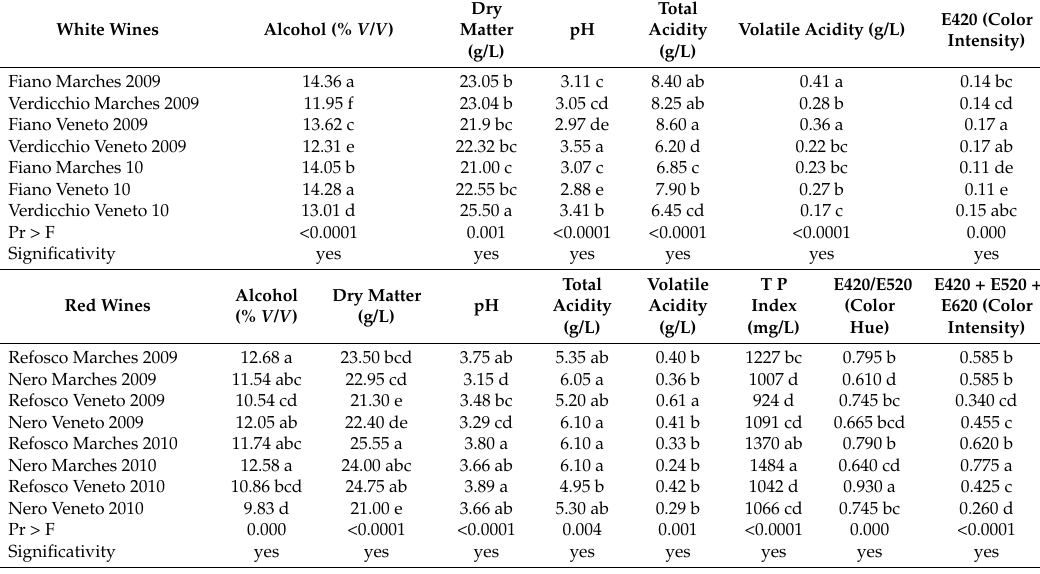
Table 4. Chemical–physical parameters determined in white and red wines in the two vintages (2009–2010). Total acidity is expressed as tartaric acid, volatile acidity is expressed as acetic acid, TP index is total phenol index. Different letters in the same column indicate significant differences at ANOVA and Tukey test